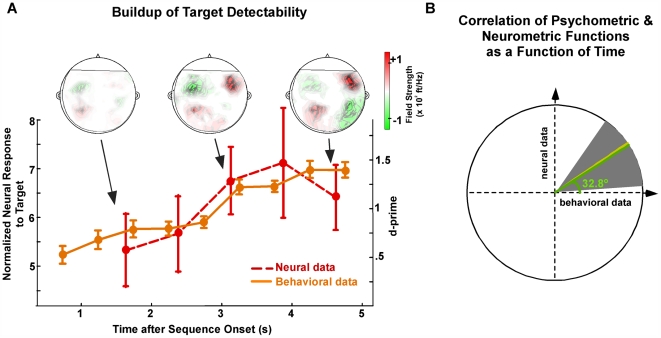
Buildup over time of behavioral and neural responses in target task.(A) Normalized neural response to target rhythm, and behavioral performance, as a function of time in target task, averaged over participants. Error bars represent standard error. Insets: the MEG magnetic field distributions of the target rhythm response component for a single participant at representative moments in time (participant 10 from Figure 2B). (B) Correlation of behavioral and neural responses as a function of time. The ratio of the neural to behavioral response trends as a function of time, interpreted as a slope angle, is averaged across participants, yielding a mean slope angle of 34.3° (yellow line). Bootstrap estimates (overlying green line) and the 95% confidence intervals (gray background) confirm the positive correlation between the psychometric and neurometric buildup curves.